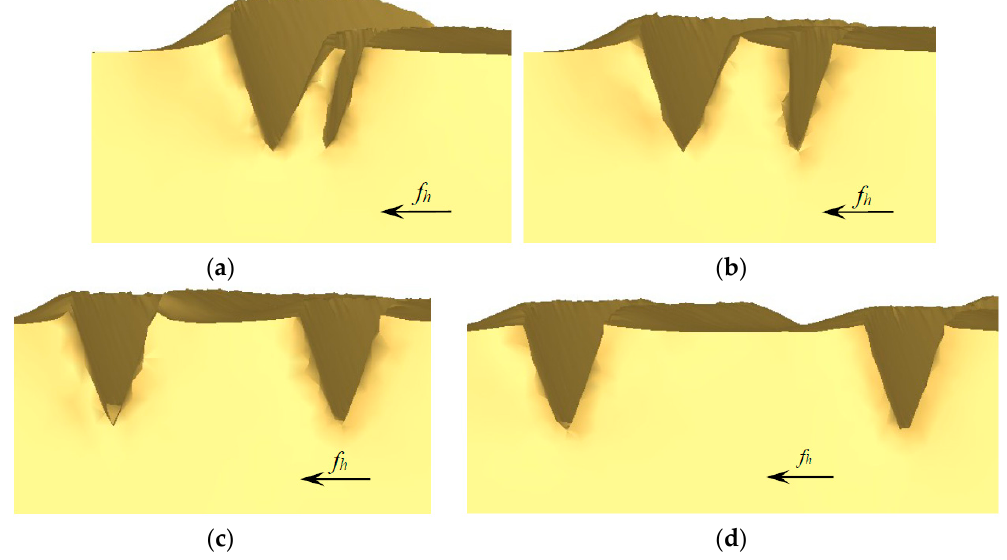
Figure 12. The morphology of microgrooves under di ff erent feedings in simulation. ( a ) A ph = 0.1 mm, f h = 0.05 mm; ( b ) a ph = 0.1 mm, f h = 0.1 mm; ( c ) a ph = 0.1 mm, f h = 0.2 mm; ( d ) a ph = 0.1 mm, f h = 0.5